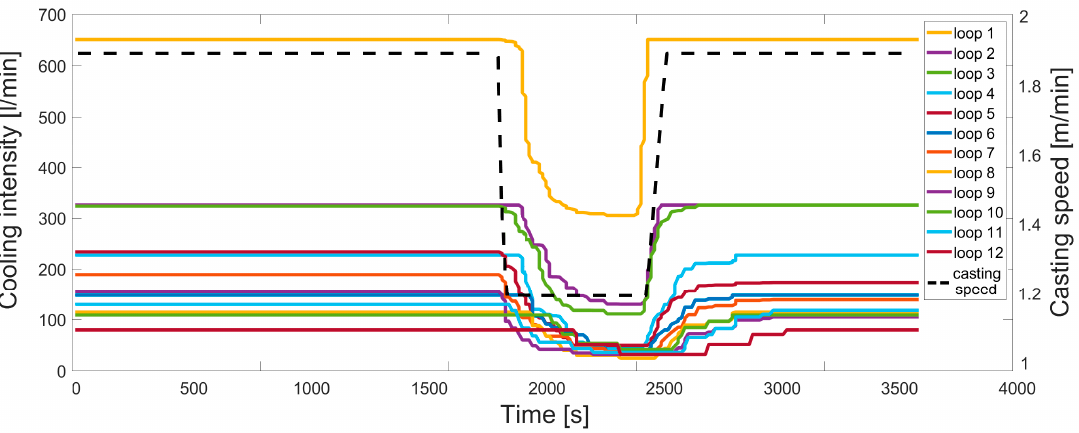
Figure 9. Dynamic response of FL regulator to casting speed drop.